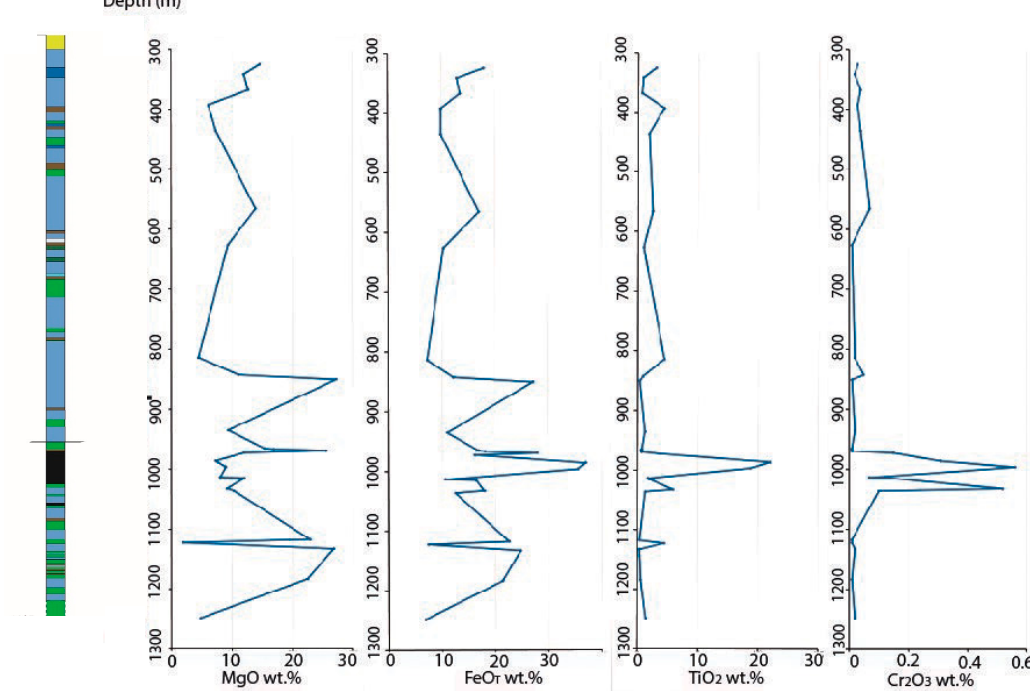
Figure 8. Stratigraphic variation plots of MgO, TiO 2 , FeO T , and Cr 2 O 3 .